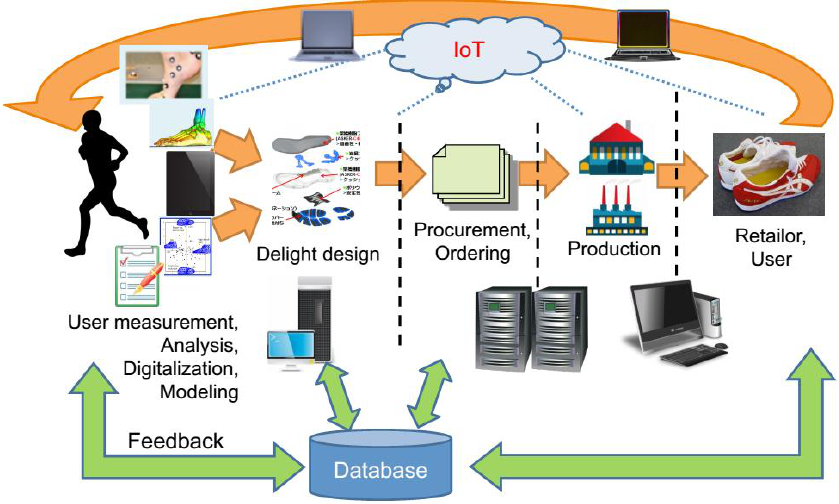
Figure 12. Proposed smart factory structure.